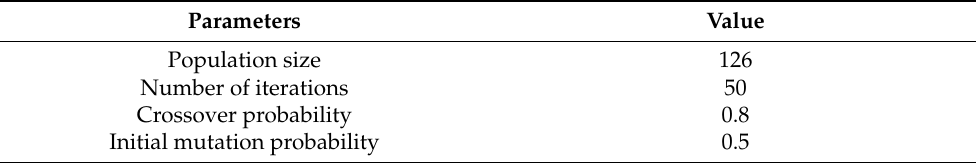
Table 2. Parameters